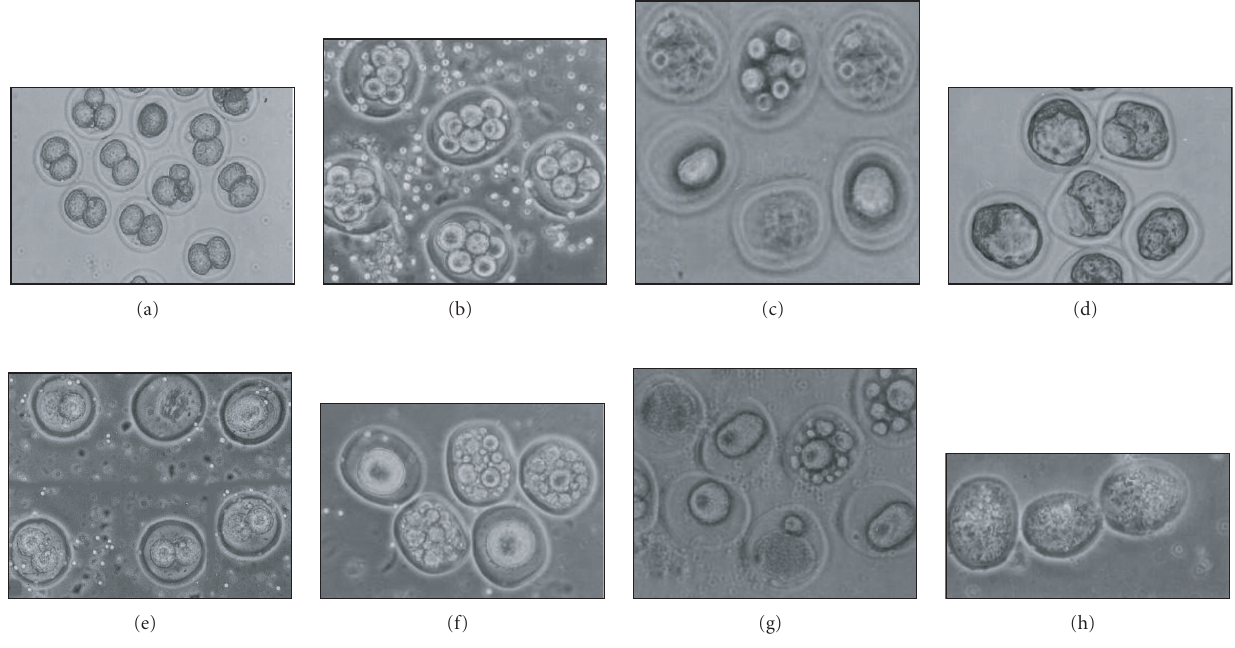
Figure 1: Photograph of embryos recovered from control and LPS-treated nonsuperovulated pregnant mice during di ff erent stages of preim- plantation period of pregnancy. Panels (a), (b), (c), and (d) show embryos recovered from control animals on days 1 . 5, 2 . 5, 3 . 5, and 4 . 375 of pregnancy, respectively. Panels (e), (f), (g), and (h) show embryos recovered from the animals treated with the “minimum dose” of LPS on days 1 . 5, 2 . 5, 3 . 5, and 4 . 375 of pregnancy, respectively,